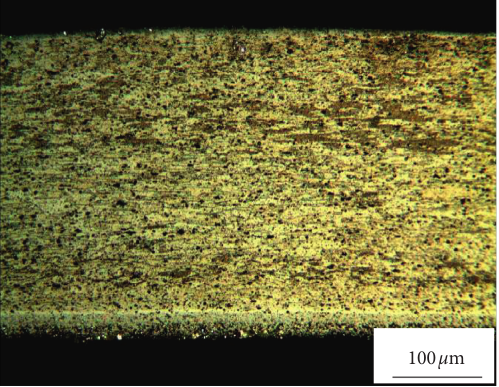
Figure 18: Microstructure of the 4343/3003/6111/3003 alloy specimen before